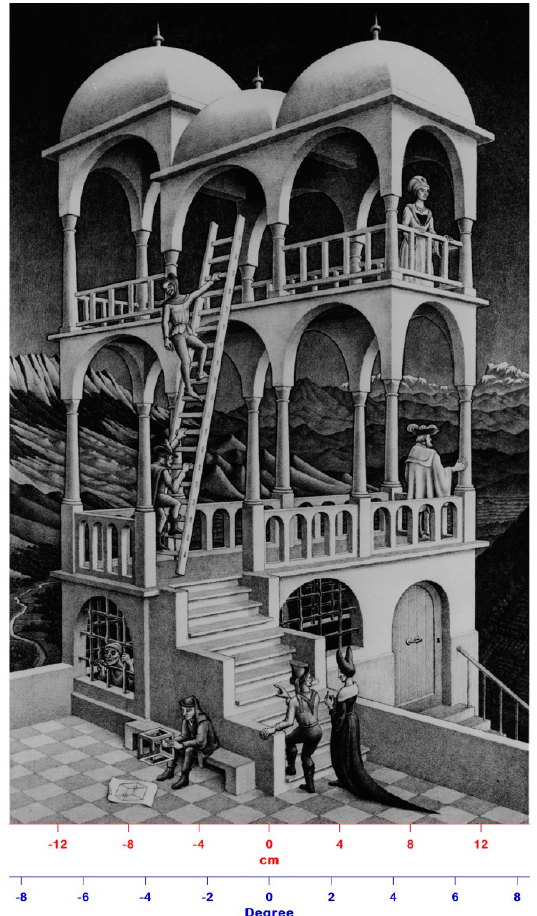
Figure 1. The Belvedere lithograph realized by Escher in 1958. The original dimensions of the artwork are 29.5 cm × 46.2 cm, which correspond to a visual angle of about 9° when the lithograph is viewed at a 1 m distance.